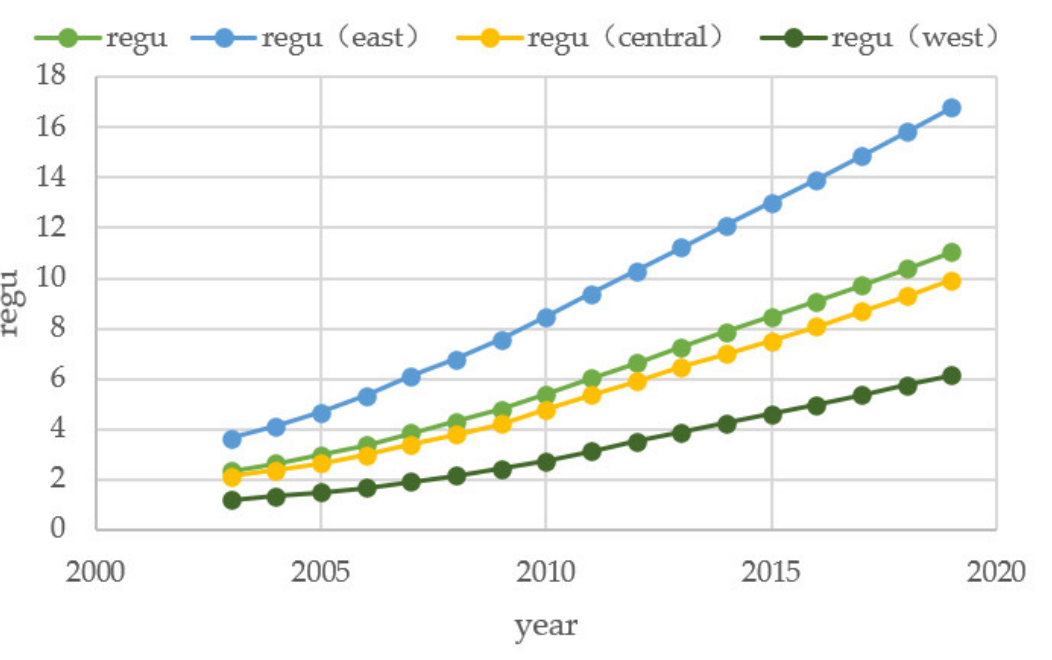
Figure 3. Average Environmental Regulation Intensity by East, Central, and West Regions, 2003–2019. In this paper, the national sample is divided into three regions, Eastern, Central, and Western, for regression to determine the choice of environmental regulatory competition strategies in different regions and the differences in the impact of regional environmental regulatory competition behavior on carbon emissions in different regions. Given that there is no uniform standard for the division of China’s regions, the 30 provinces, autonomous regions, and municipalities directly under the central government studied were divided into three regions based on the division method used in the collation of statistics from the National Bureau of Statistics in 2018. The regression results are shown in Table